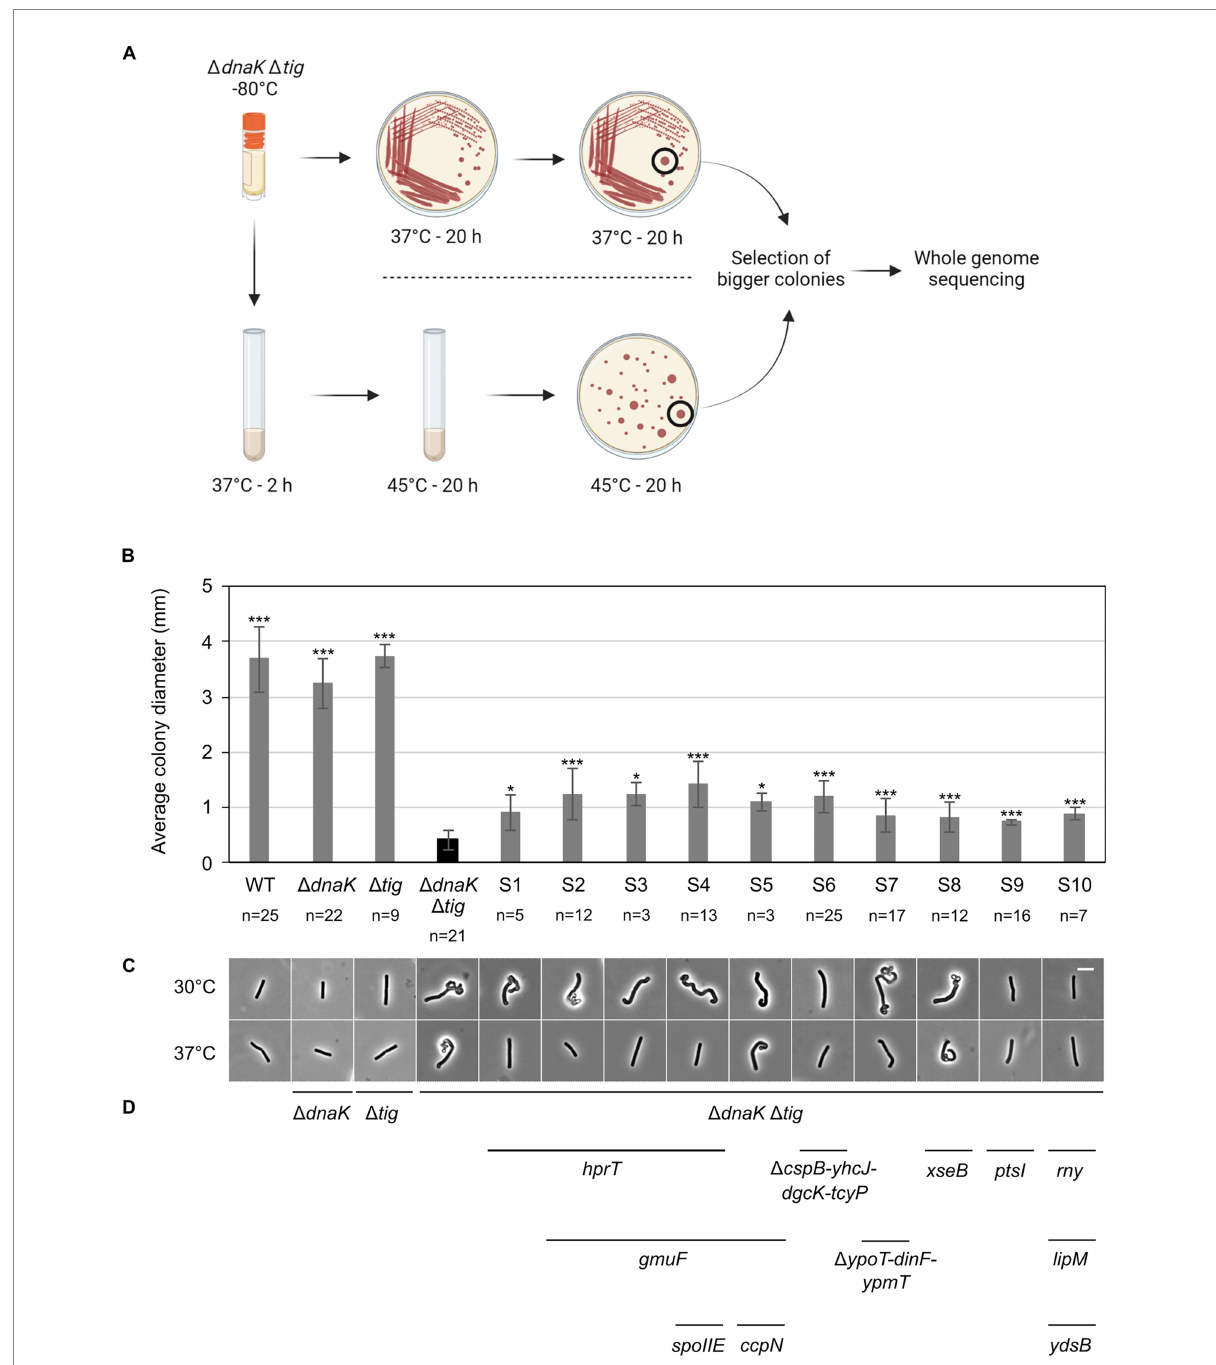
FIGURE 7 Isolation of LUW878 ( Δ dnaK Δ tig ) suppressors with partially restored colony size and cell morphology. (A) Isolation of LUW878 suppressors was achieved by two methodological approaches. In the first approach, the strain was streaked for single colonies from a glycerol stock stored at − 80 ° C onto a TBAB plate. After an overnight incubation at 37 ° C, cells were re-streaked and incubated again at the same temperature. Suppressor mutants were isolated from the plates by selecting colonies that were larger than LUW878 itself. In a second approach, LUW878 was grown in 2 ml LB liquid medium at 37 ° C for 2 h, and then shifted to 45 ° C for another 20 h. Bacteria in different dilutions were plated on TBAB and grown at 45 ° C overnight. Suppressor mutants were isolated by selecting larger colonies. In total, ten suppressors were isolated and whole-genome sequenced. (B) Average colony diameters of the ten selected Δ dnaK Δ tig suppressors (S1–S10). n denotes the number of colonies on each plate. Colony diameters were measured with Fiji (Schindelin et al., 2012). Asterisks indicate p -values from two-tailed heteroscedastic t -tests with the null hypothesis Østrain = ØLUW878; *: value of p < 0.05; ***: p < 0.001. (C) Representative phase contrast micrographs of the isolated suppressors. Cells for imaging were taken from single colonies present on overnight TBAB plates incubated at 30 ° C or 37 ° C. The scale bar represents 5 μ m. (D) Genes, identified through whole-genome sequencing, that either where deleted or contained point mutations are indicated below the micrographs of the respective suppressor